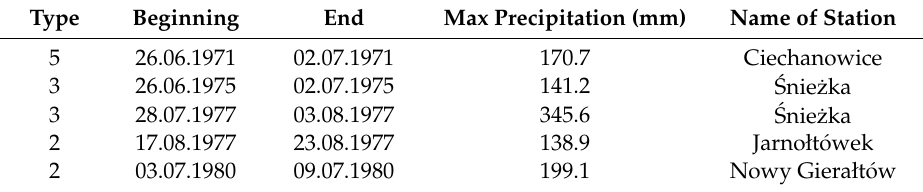
Table A1. Floods characteristics with the type they belong to, beginning and end dates, maximum precipitation in the week preceding flood culmination (with a name of